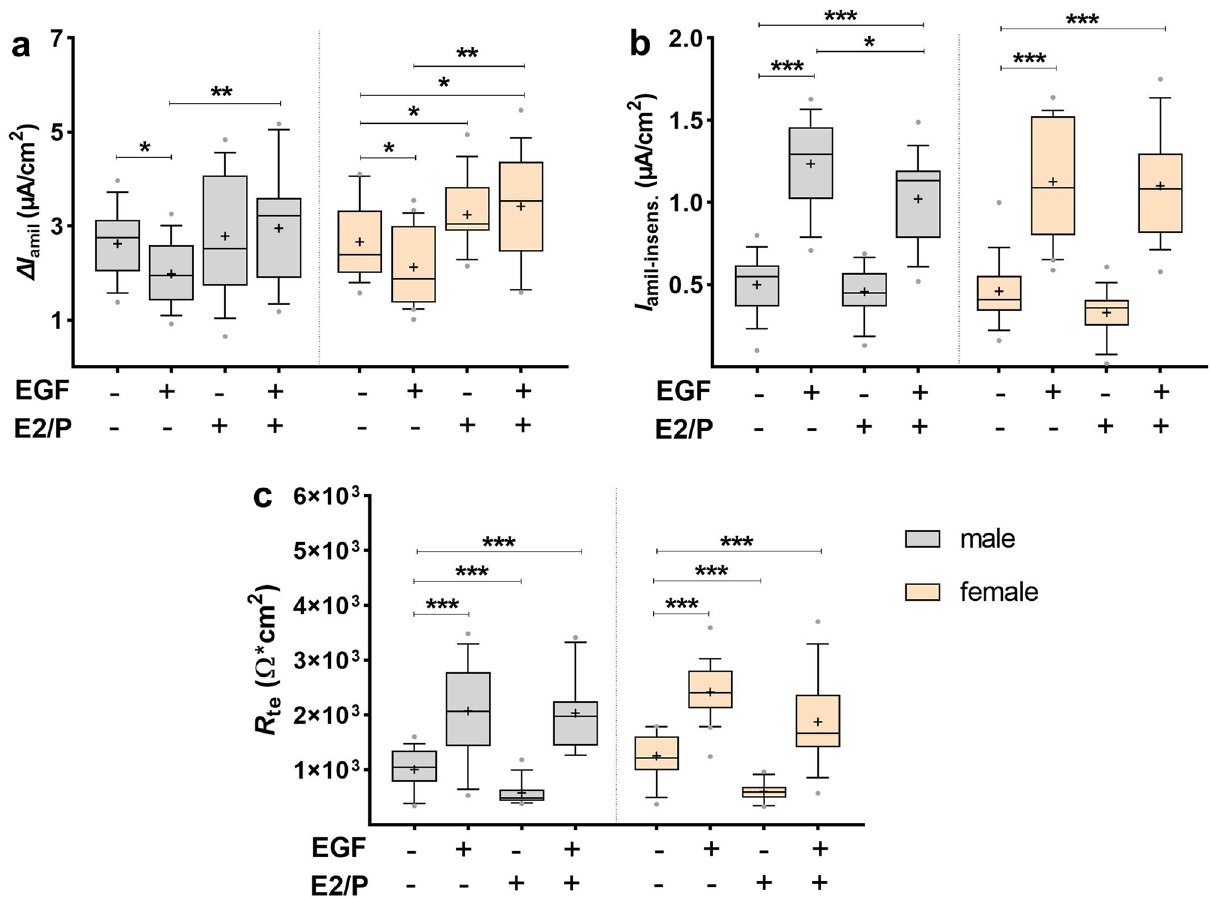
Figure 10. Female sex steroids prevented the reducing effect of EGF on Na + transport. FDLE cells were cultured in SF-Med and stimulated with EGF with or without female sex steroids (E2/P). Data are displayed as box and whiskers with the 10–90 percentile, mean (+) and median (horizontal line). ( a ) EGF significantly decreased Δ I amil in male FDLE cells, which was reversed by the addition of E2/P (n = 16–18; * p < 0.05; ** p < 0.01 by t -test). Moreover E2/P stimulated Δ I amil in females and prevented the reduction induced by EGF (n = 15–18; * p < 0.05; ** p < 0.01). ( b ) EGF significantly increased I amil-insens in both male and female FDLE cells, which persisted in the presence of E2/P (* p < 0.05; *** p < 0.001). ( c ) EGF significantly increased R te , while E2/P reduced R te in male and female FDLE cells. In addition, EGF prevented the decrease of R te induced by E2/P (** p < 0.01; *** p < 0.001). (Grey boxes) male; (yellow boxes)